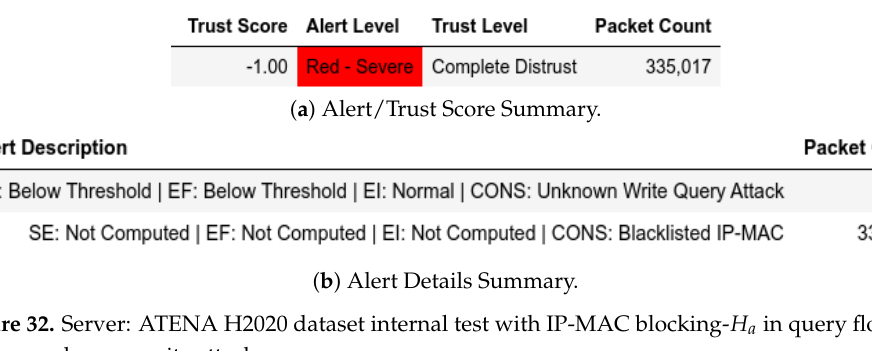
Figure 31. Server: ATENA H2020 dataset internal test with IP-MAC blacklisting- H a in MitM capture- baseline replay to final strike.